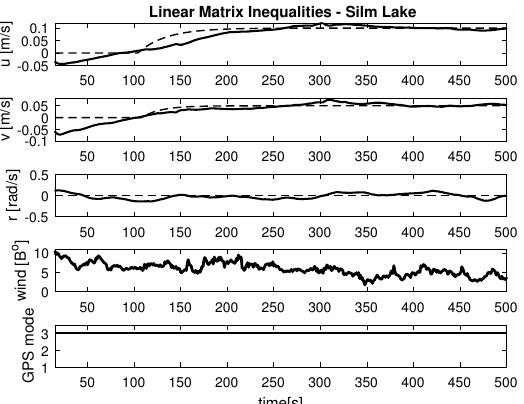
Figure 12. Ahead maneuver with longitudinal velocity u = 0.1 [m/s], v = 0.05 [m/s], r = 0.0 [rad/s], wind [ B o ] and GPS mode [-], maneuver duration 500 [s].